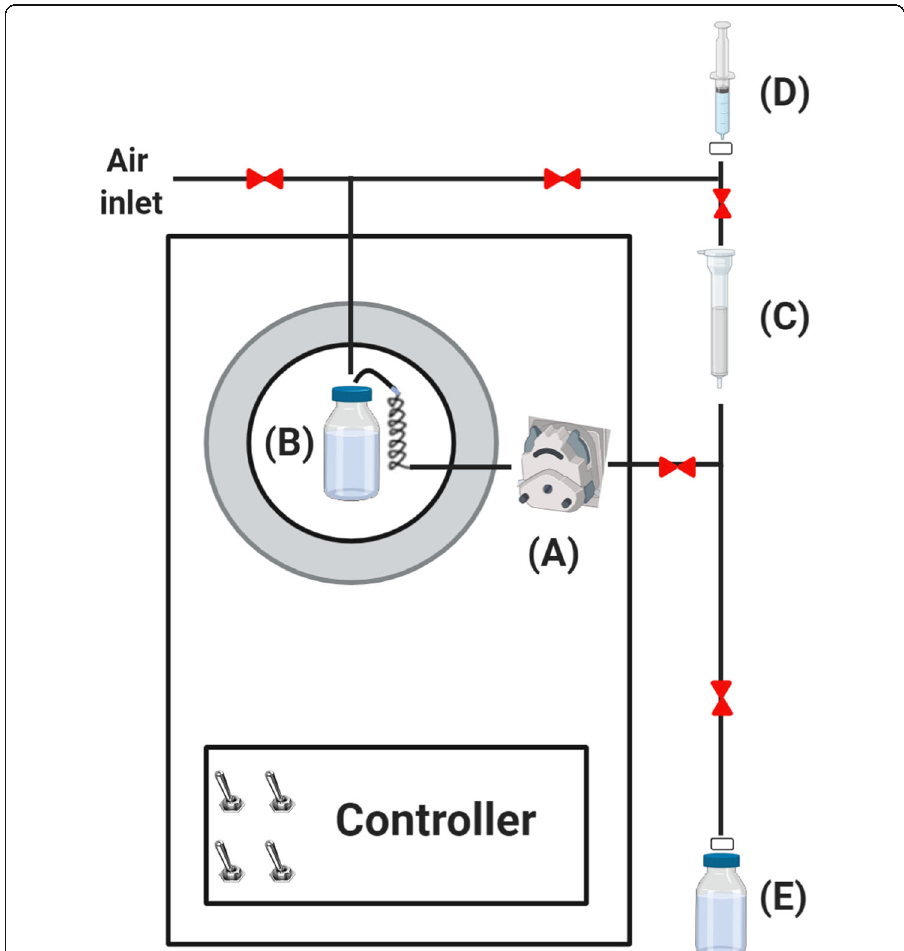
Fig. 3 Schematic of the 228 Th/ 212 Pb generator. a Peristaltic pump. b Generator stock solution in lead shielded storage loop. c Pb resin column. d Syringe attached to a female luer fitting to control elution. e Collection vial for 212 Pb(OAc) 2 . Image created with